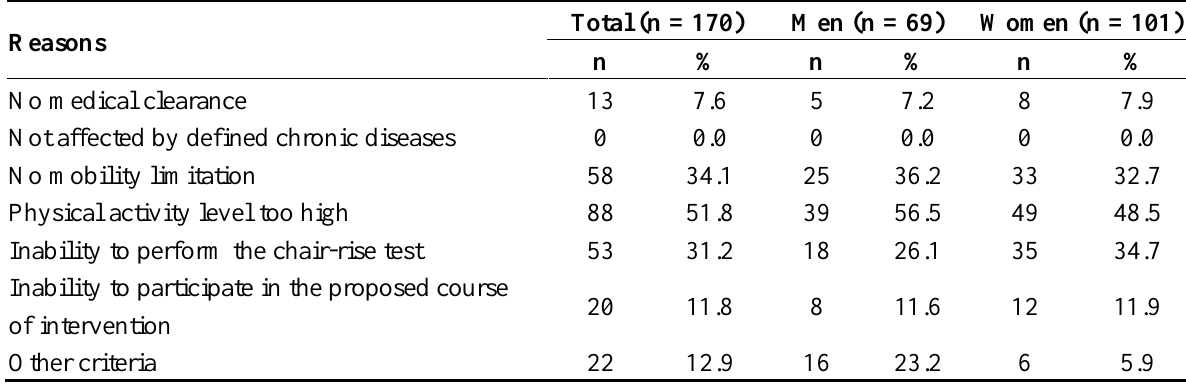
Table 4. Reasons for non-eligibility as determined during the screening at the GP’s practice (multiple answers allowed).